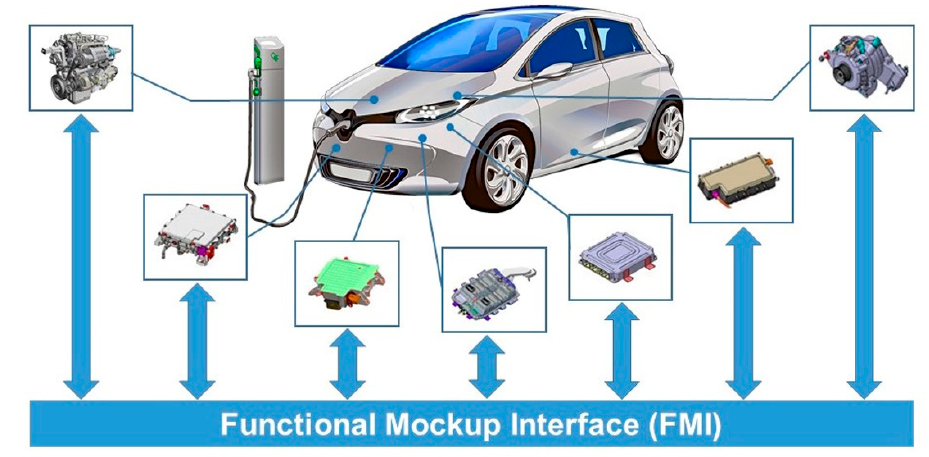
Figure 1. FMI-based simulation in the electric vehicle (EV) domain